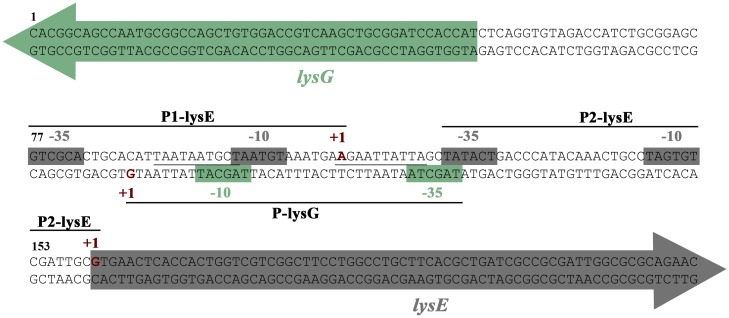
Genomic organization suggest a LTTR-dependent regulation of lysE(Mt).A 108 bp region separates lysG(Mt) from lysE(Mt). The lysG(Mt) and lysE(Mt) transcriptional start sites are indicated with +1 (in red and bold type). The coloured arrows denote the beginning of the ORFs. The promoter binding motifs (-10 and -35 motifs) are marked as boxes. The underlined base pairs represent a palindromic DNA sequence.